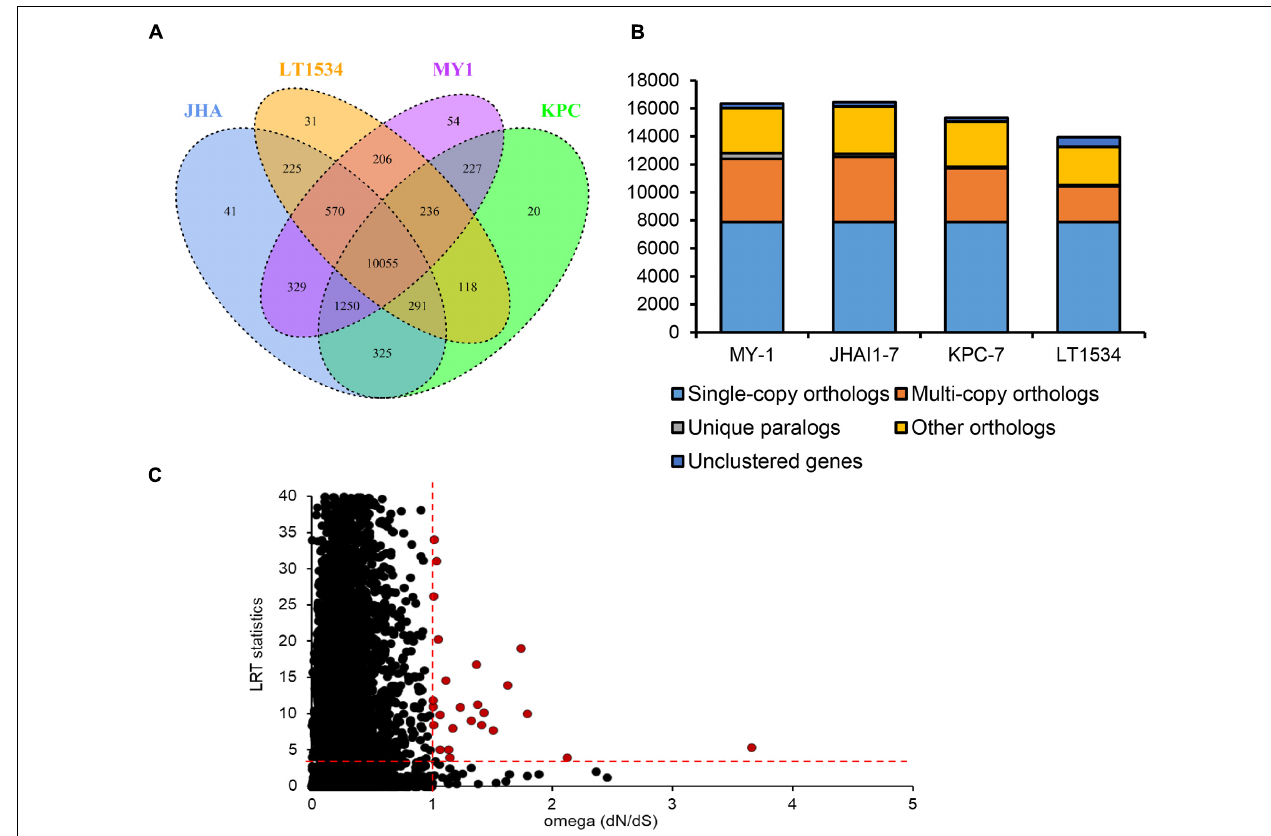
FIGURE 2 | Gene orthology analysis of the P. capsici genome assembly. (A) Venn diagram showing the numbers of unique and shared gene families among four P. capsici isolates. (B) Distribution of orthologous genes in the four P. capsici strains. (C) Positive selection signals of the single-copy orthologous genes. The red circles indicate positively selected single-copy orthologous genes, while the black circles represent orthologous gene pairs that were not significantly positively selected. The red dotted lines represented the criteria for positive selection (dN/dS > 1.0; Chi-square value for LRT statistics ≥